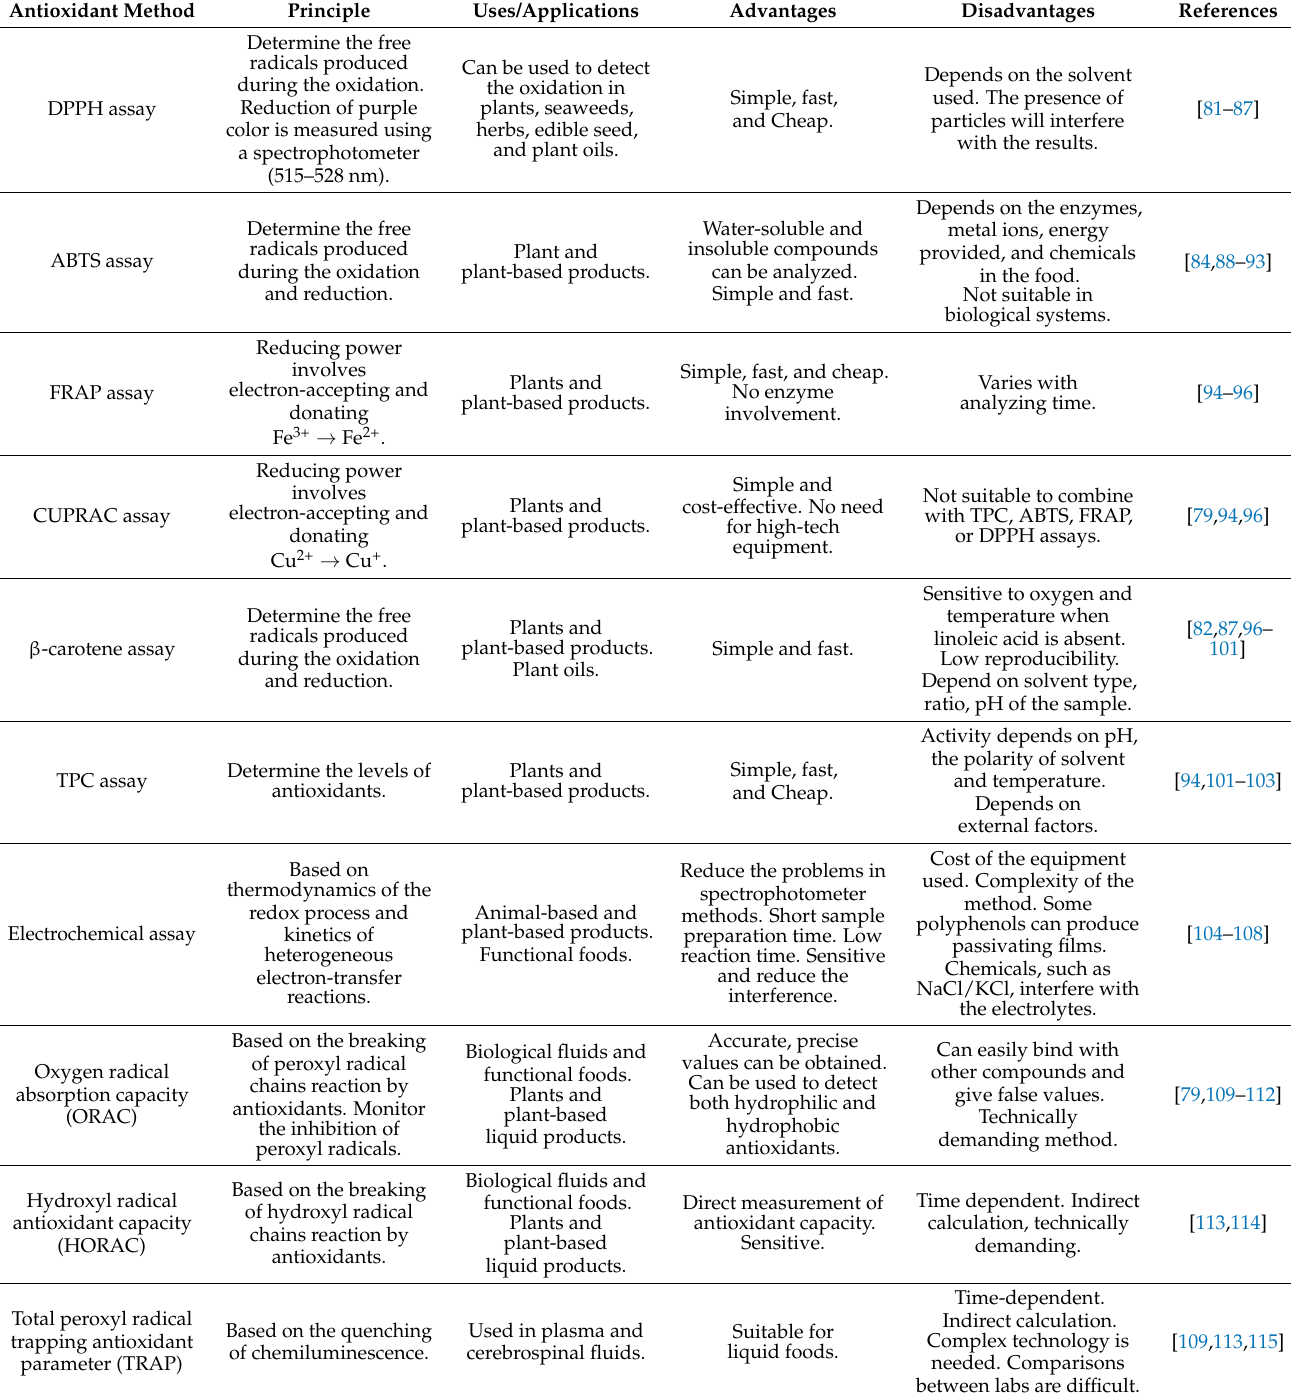
Table 2. Summary of the methods used to measure the antioxidant capacity of